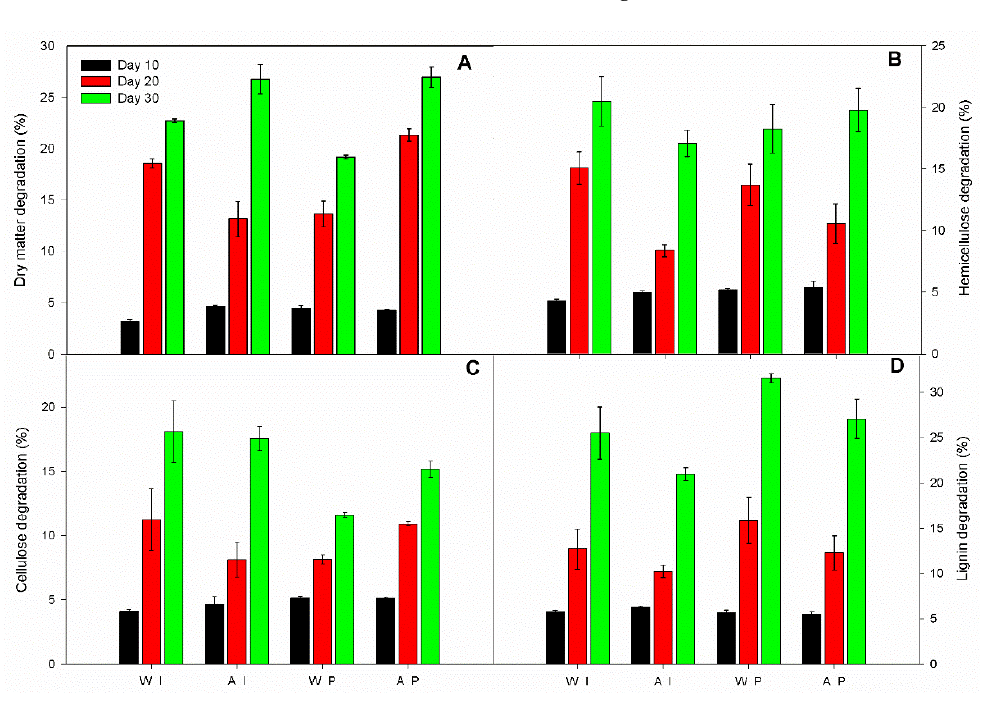
Figure 3. Degradation (%) of giant reed components: ( A ) dry matter, ( B ) hemicellulose, ( C ) cellulose, and ( D ) lignin during 10, 20 and 30-day fungal pretreatment in winter and autumn I. lacteus pretreatment (WI and AI, respectively), and winter and autumn P. ostreatus pretreatment (WP and AP, respectively). Significant interaction (LSDint p ≤ 0.05) for: (i) dry matter (2.76), hemicellulose (2.85), cellulose (1.33), and ADL